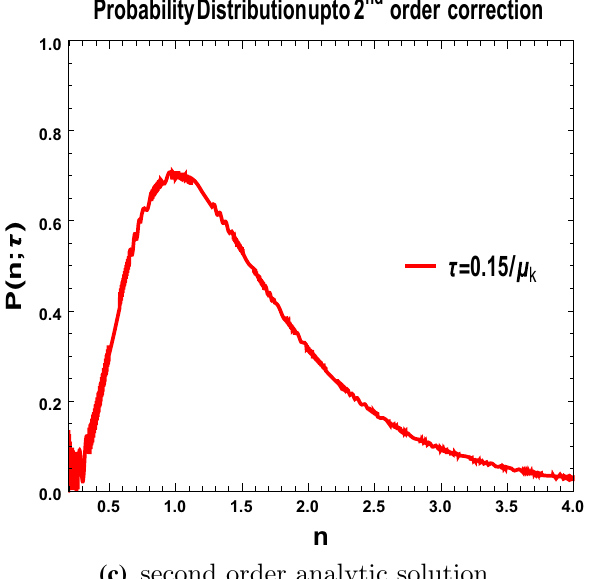
Fig. 45 Second order corrected probability distribution profile for different m 2 with previously mentioned initial conditions. Here we fix m = 2. Here the subscript 1 and 2 stands for the corrected order in the